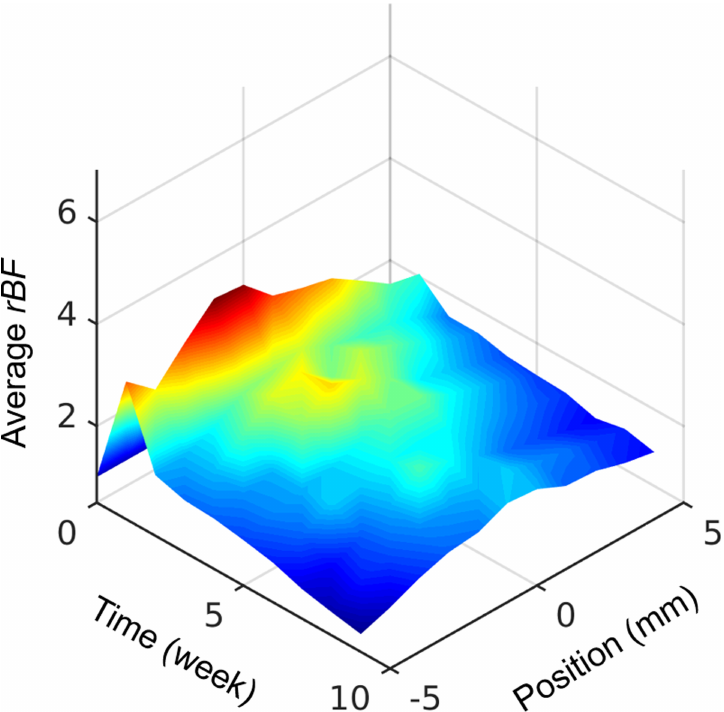
Fig 4. Blood flow changes in different femur segments over a 9-week healing. Average rBF was calculated as the average of all mice (N = 19). Position on the femur is illustrated in Fig 2, with the center of the graft as the origin.